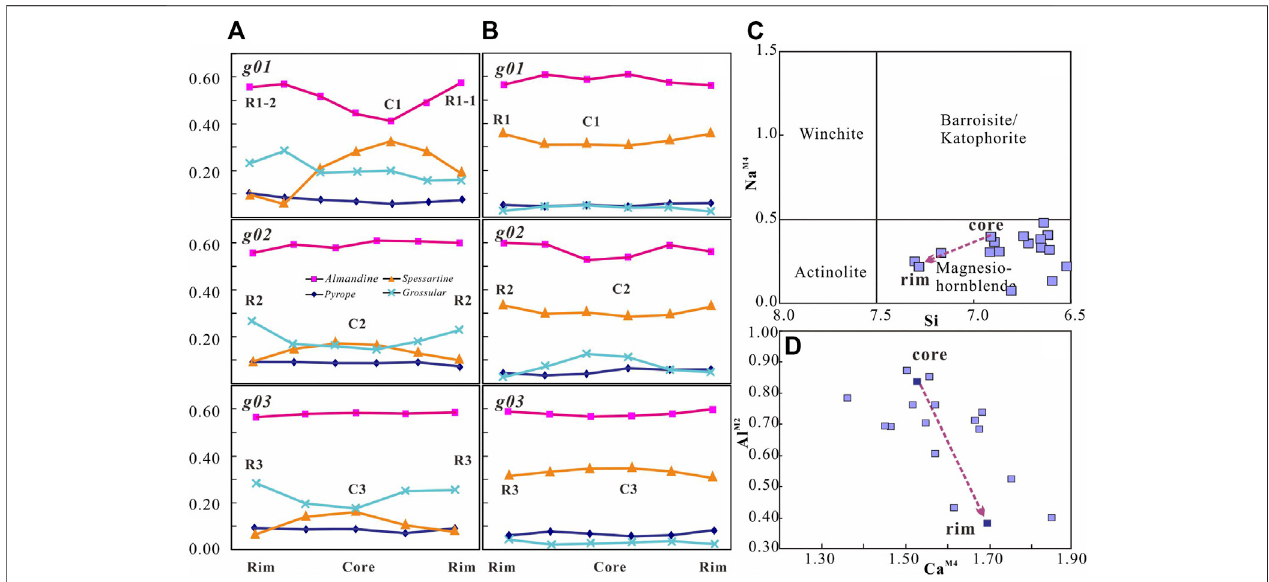
FIGURE5 | The zoning pro fi les of almandine, pyrope, grossular and spessartine for the representative garnet grains in sampleEL01 (A) and sample EL08 (B) , and the Si vs . Na M4 p. f.u. (C) and Ca M4 vs . Al M2 (D) diagram showing the compositions of amphibole in the sample EL08 (after Leake et al., 1997).